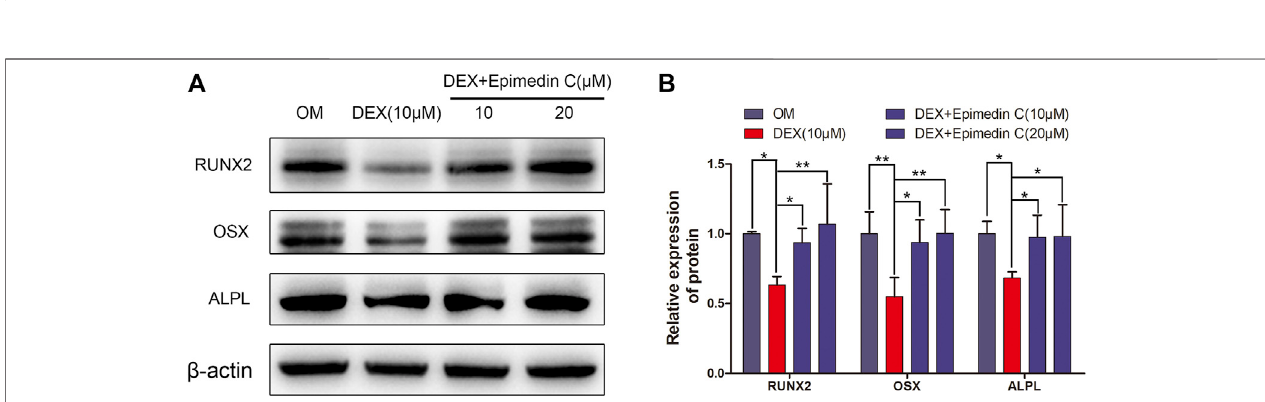
FIGURE 4 | Epimedin C enhanced the OSX, RUNX2, and ALPL protein expression in MC3T3-E1 Cells treated with DEX. (A) Following 7 days of MC3T3-E1 cells treatment using epimedin C and DEX in OM, the protein was extracted by 10 percent SDS-PAGE and identi fi ed using the speci fi ed antibodies of OSX, RUNX2, and ALPL. As a loading control, β -actin was employed. (B) The bar charts depicted ImageJ ’ s measurements of RUNX2, OSX, and ALPL. DEX: dexamethasone; OM: osteogenic induction medium. * p < 0.05, ** p < 0.01.